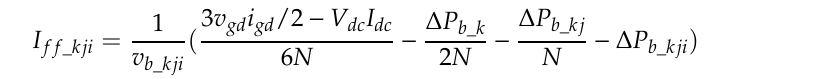
Figure 11. Improved control strategy based on moving average filter (MAF) for individual bidirectional DC/DC